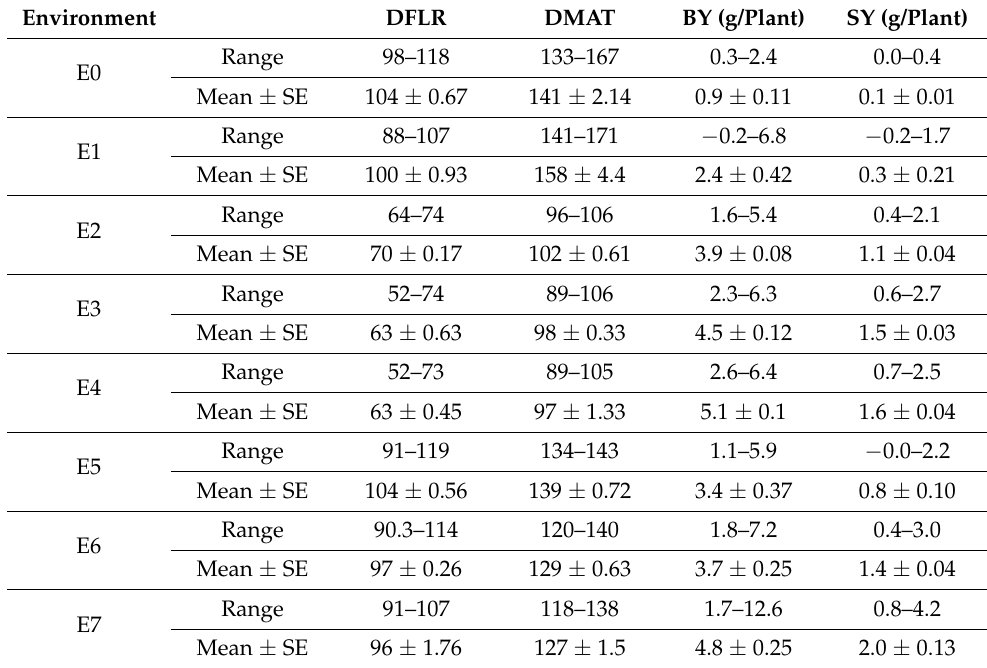
Table 3. Mean ± Standard error (SE) and ranges for different traits in diverse environments.